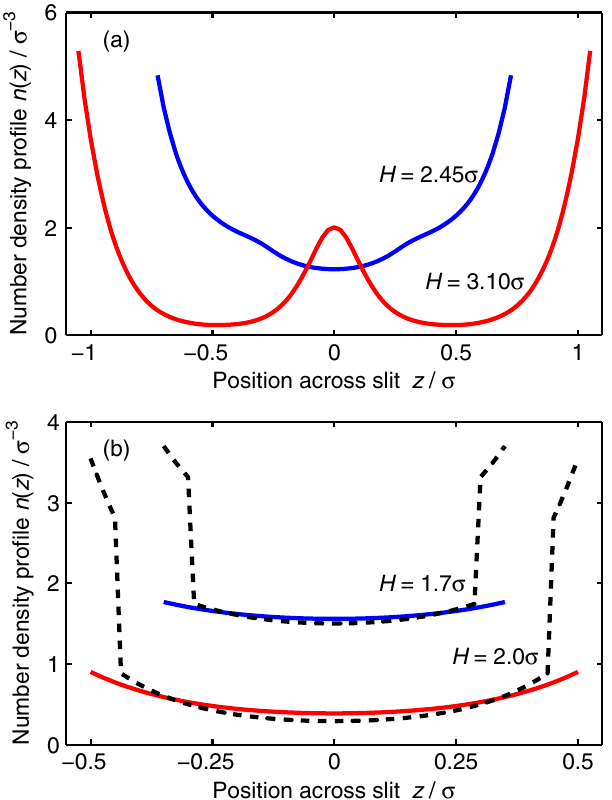
FIG. 3. Theoretical number-density profile n ð z Þ corresponding to the local volume fraction profiles C ð z Þ of Fig. 2, obtained within the APY theory. Data are presented for (a) the dense hard- ¼ 0 . 75 σ − 3 ) between hard planar walls as well as sphere fluid ( n b ¼ 0 . 38 σ − 3 ) for (b) the moderately dense hard-sphere fluid ( n b between either hard (solid lines; βϵ ¼ 0 ) or slightly sticky hard planar walls (dashed lines; βϵ ¼ 1 . 1 ). Data for different slit widths H are vertically offset by 1.0 units for